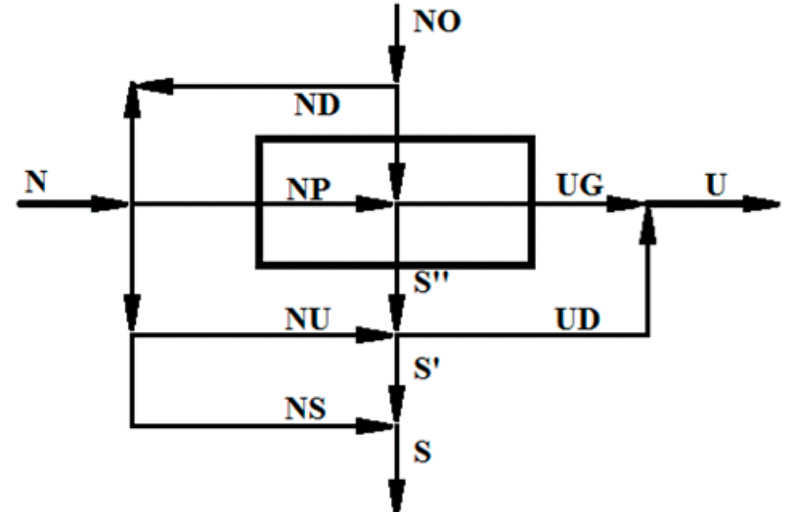
Figure 2. Model of an operation system: N direct outlays, NP process-related outlays, NU , NS processing related outlays, ND utilization outlays, NO protection outlays; effects: U functional, UG general, UD additional; losses: S unrecovered, S ’ useful, S ” process related. Authors’ own study.